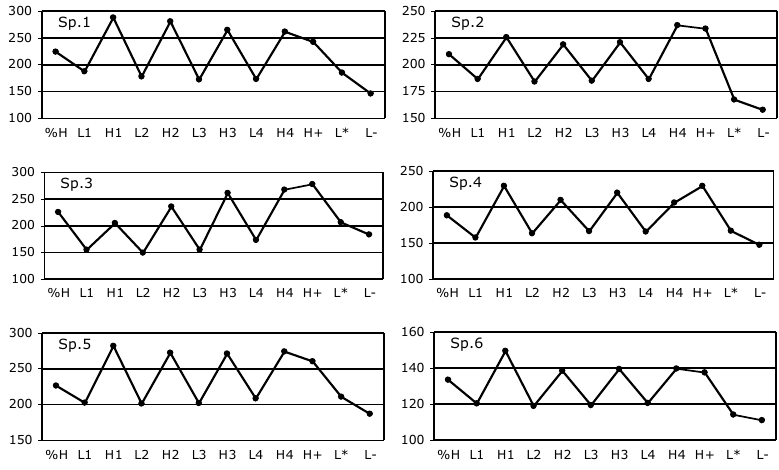
Figure 6. F0-measurements of the peaks and valleys of the lists, separated by speakers.